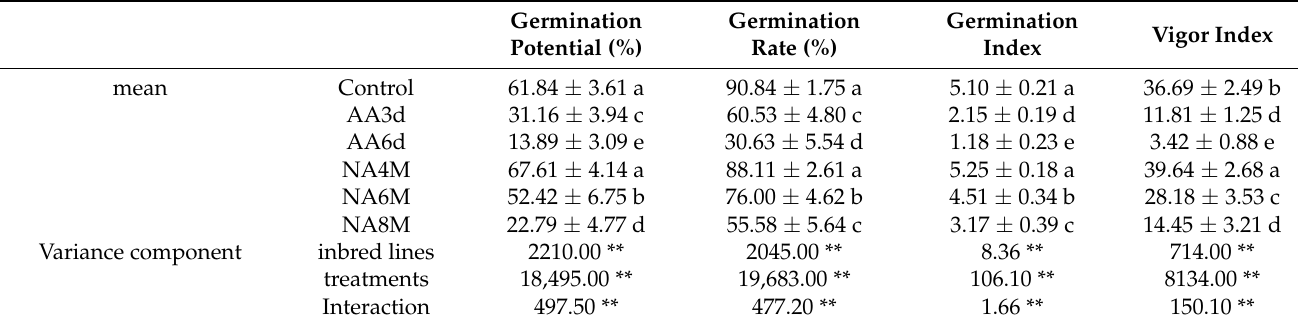
Table 1. Phenotypic performance and variance components of four seed vigor traits in 19 sweet corn